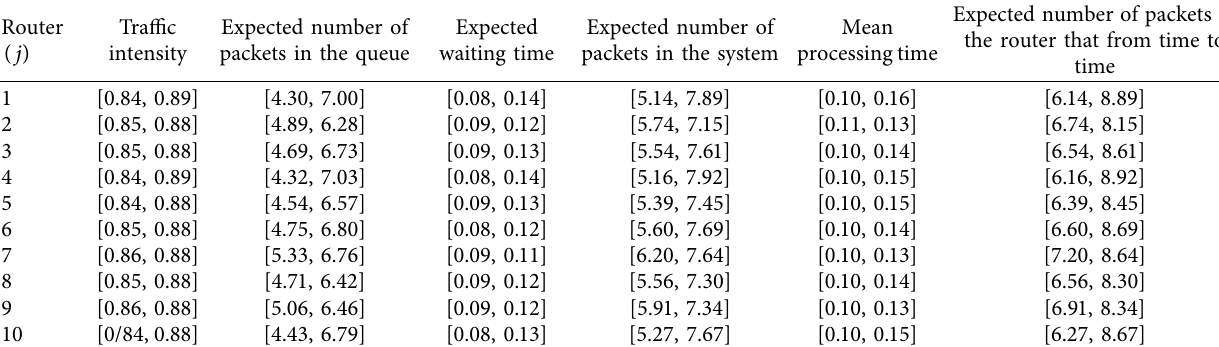
Table 11: Different characteristics of the proposed data network for α � 0 .